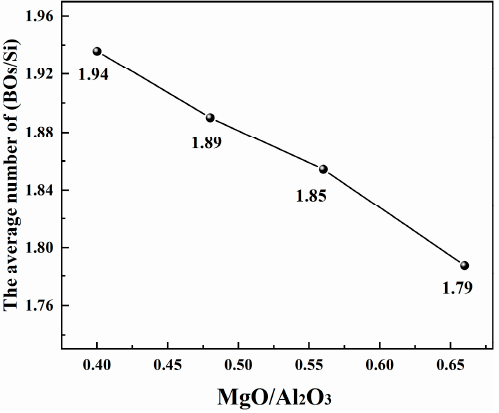
Figure 12. Influence of MgO/Al 2 O 3 on average (BOS/Si).